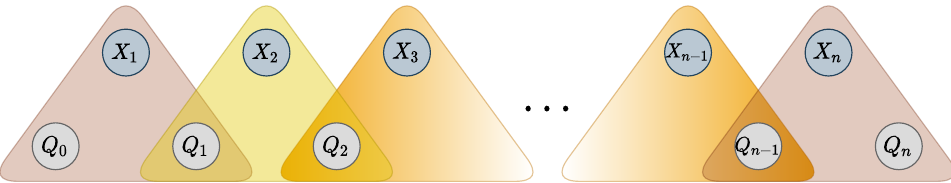
Figure 4. Hypergraph representation of the decomposition of a WR EGULAR cost function with additional state variables Q i and transition-encoding ternary